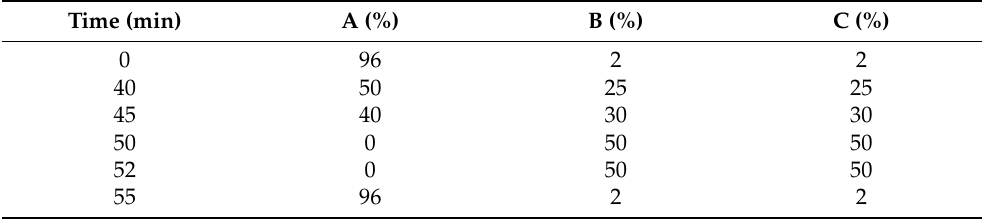
Table 1. HPLC mobile phase gradient *.